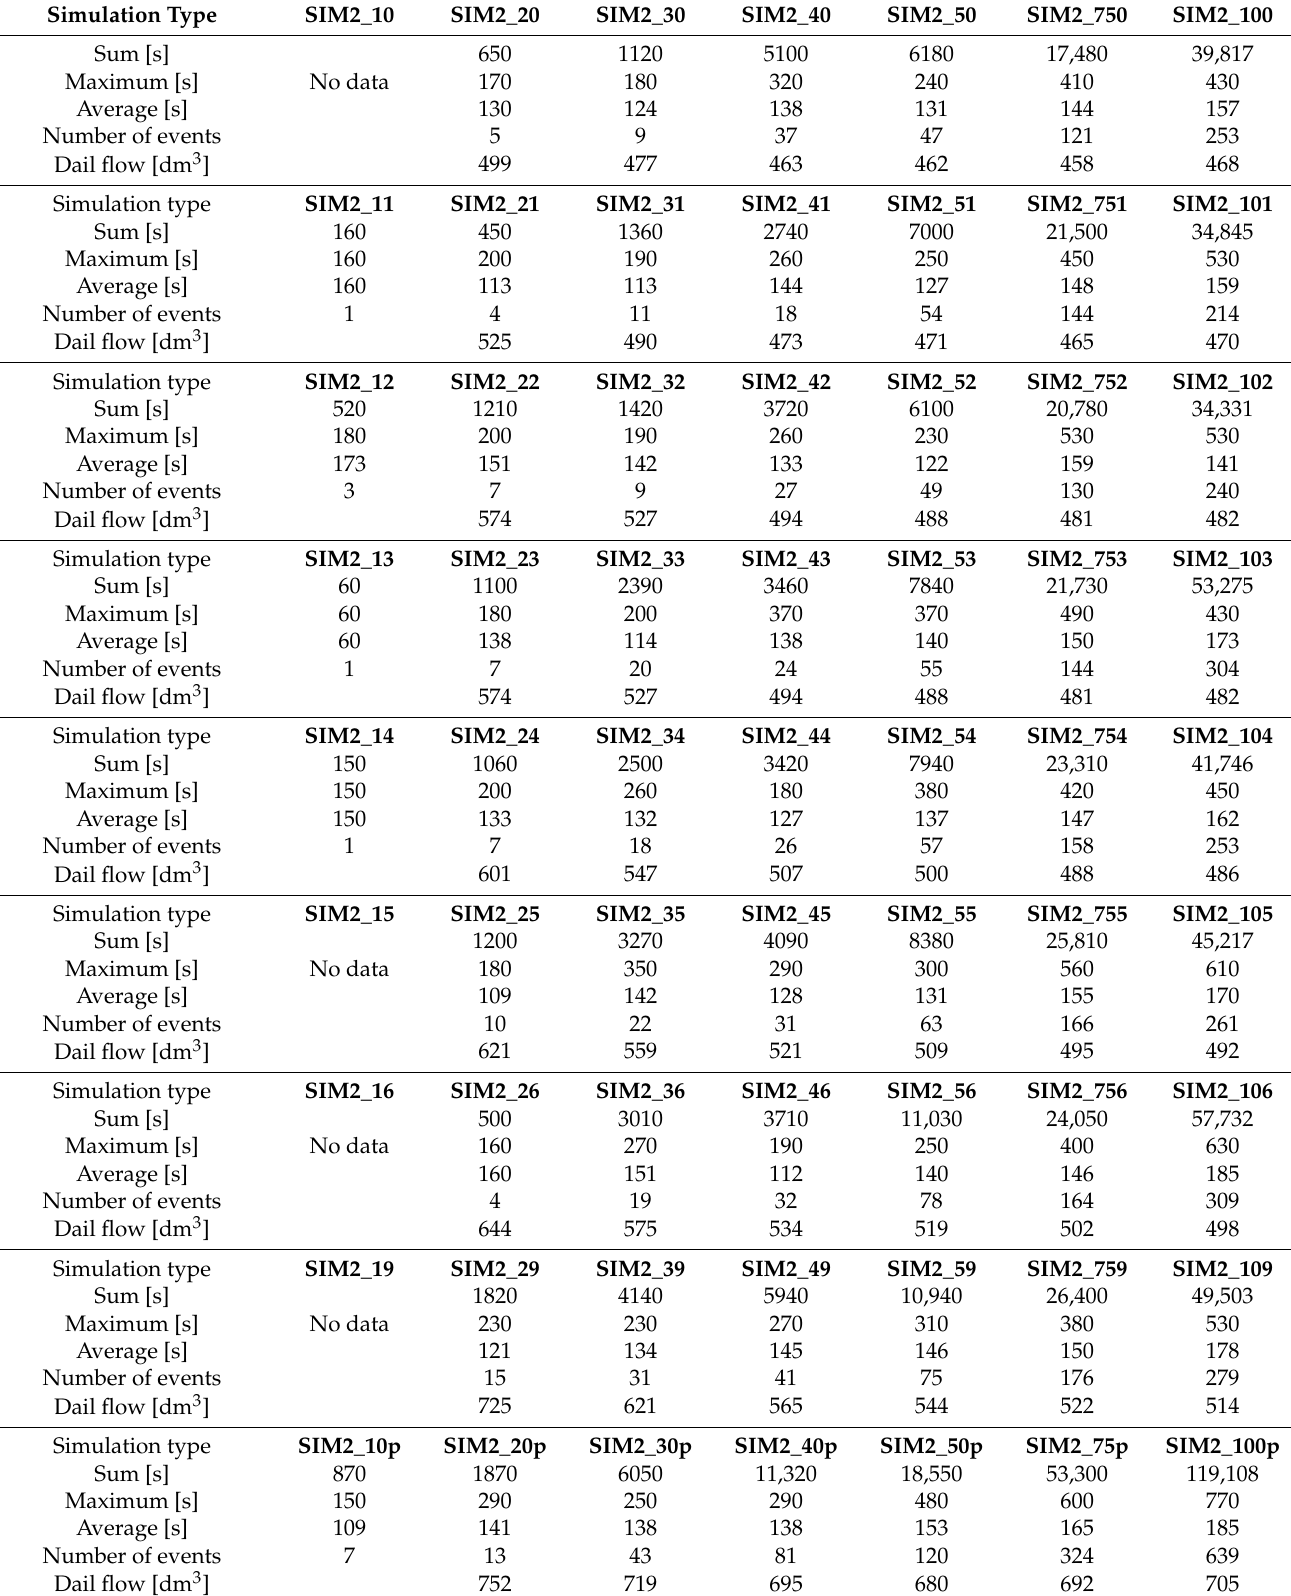
Table A2. Simultaneous operation parameter listings for a pumping station with V = 296 dm 3